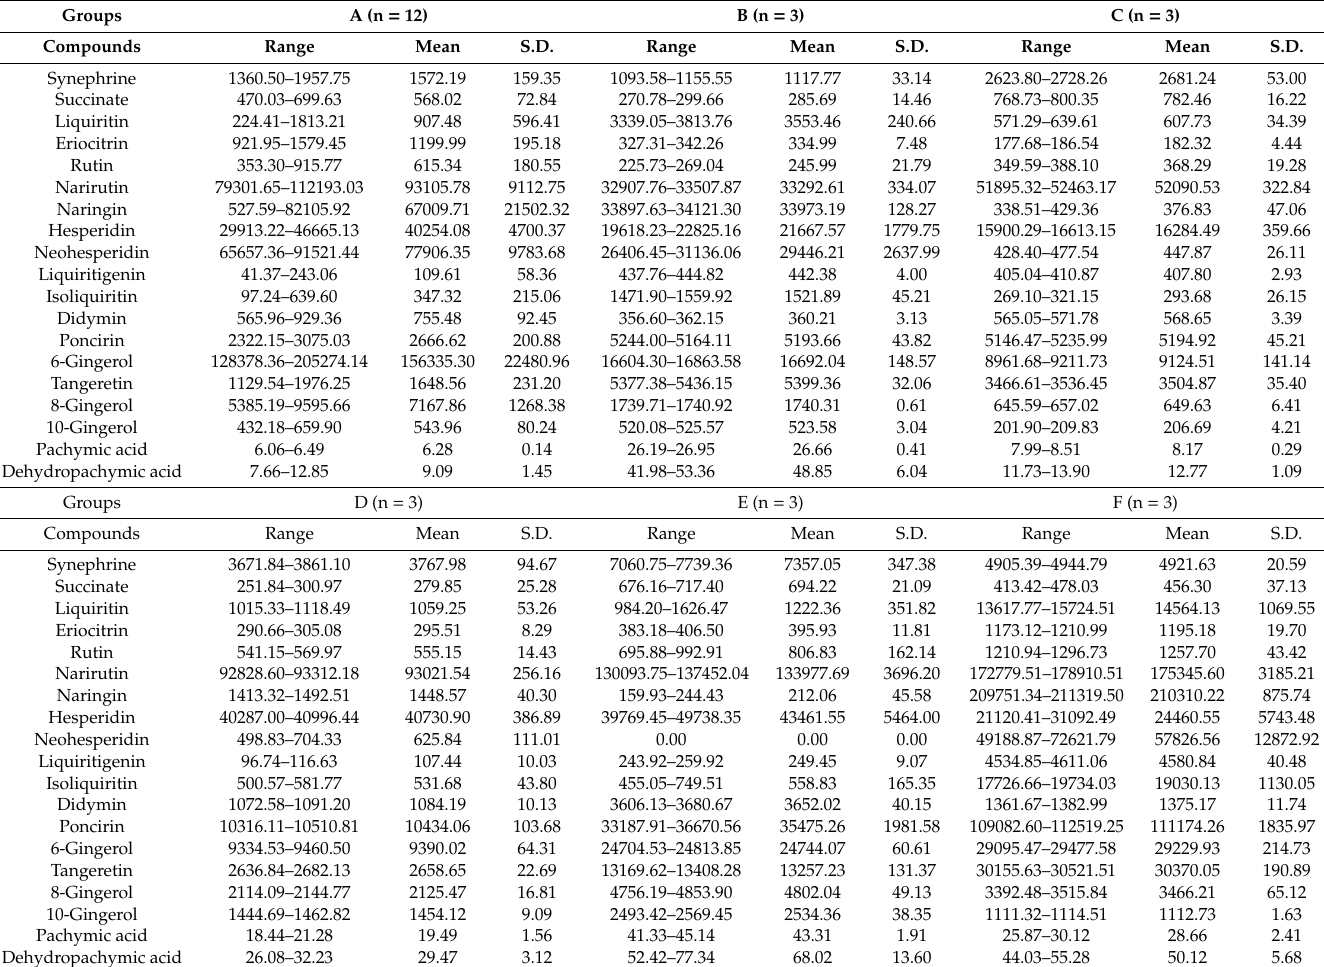
Table 4. The range, the mean and standard deviation of the 19 chemical contents in a daily dose of WDD prepared in the lab and its five brands commercial preparations ( µ